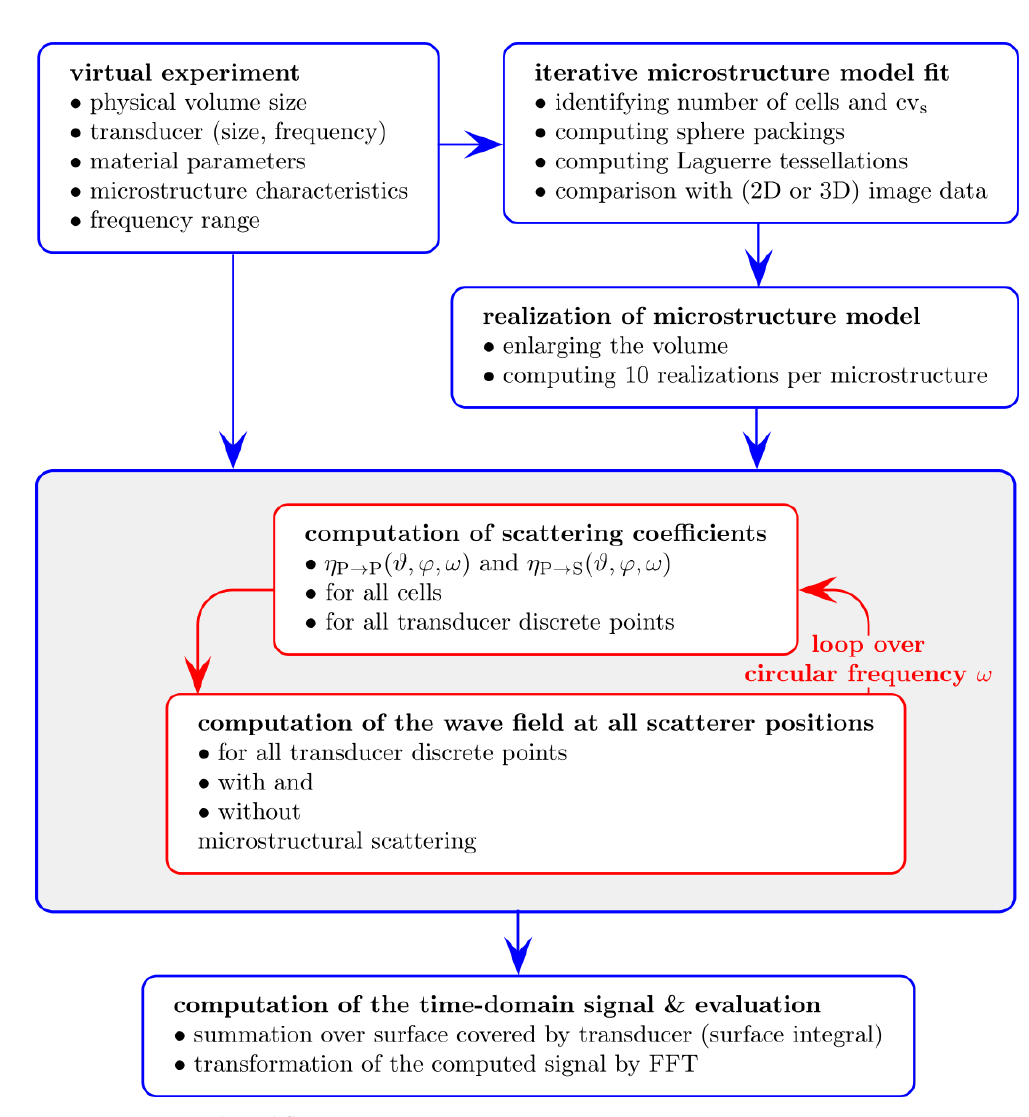
Figure 2. Proposed